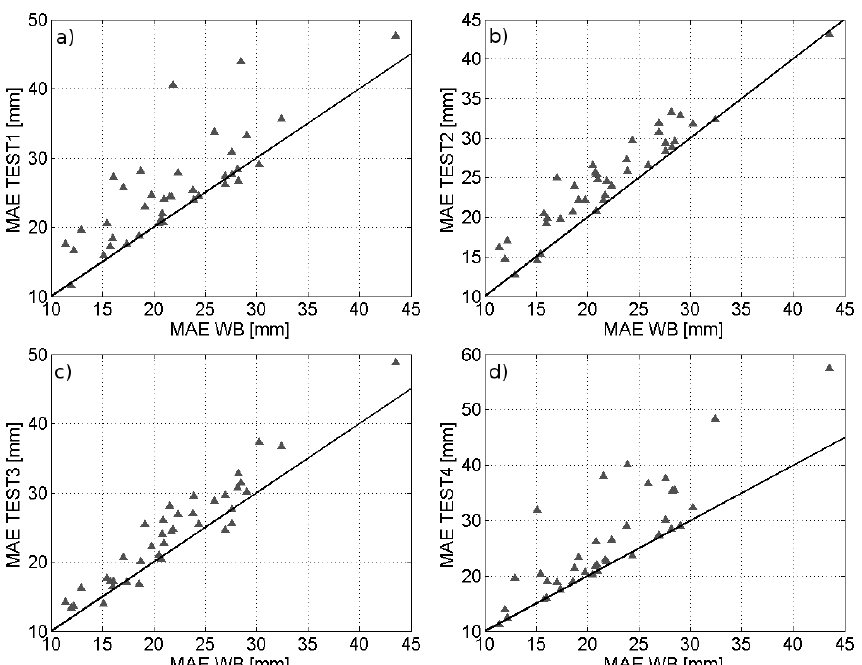
Fig. 8. Evaluation of the model assumptions, local scale application. On the horizontal axis there is the MAE of the water balance model. On the vertical axis the MAE of the model: (a) without temperature variability; (b) without storm runoff; (c) with snowmelt modelled by a linear degree-day approach; (d) without precipitation